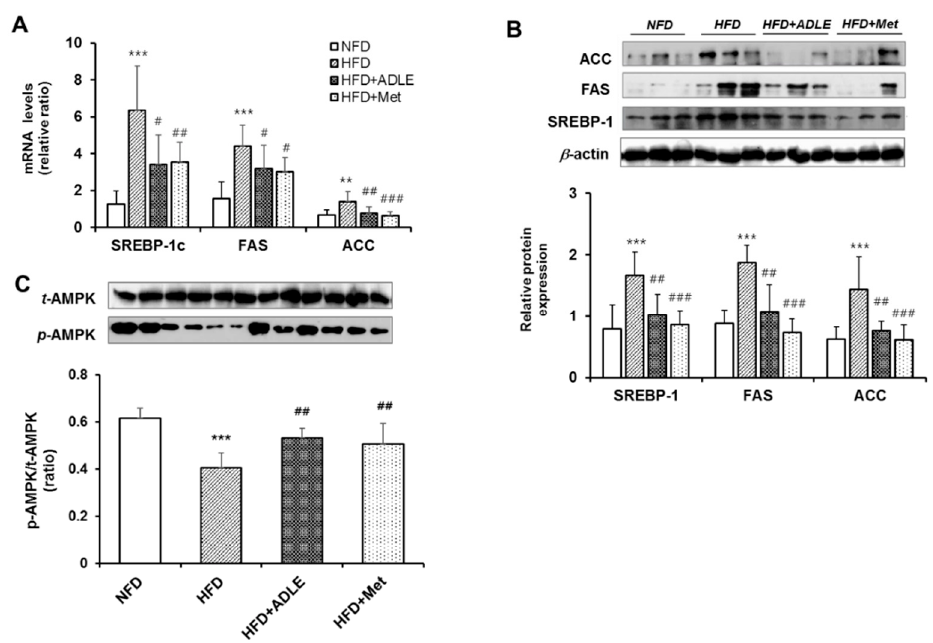
Figure 7. ADLE reduced the expression of lipogenic genes and dephosphorylation of AMPK in the liver of HFD-induced diabetic mice. Mice were treated as described in Figure 1. After 6 weeks of ADLE treatment, total RNA and protein were extracted from the liver as described in the Materials and Methods section. ( A ) The qRT-PCR analysis of gene expression for SREBP-1c, FAS, and ACC was normalized with those of cyclophilin. ( B ) Protein expression levels of SREBP-1, FAS, and ACC were measured by western blot analysis. The intensity of the bands was quantified by densitometric analysis and normalized with corresponding β -actin. ( C ) Western blots of phosphorylated AMPK (pAMPK) in the liver were performed, and the intensity of the bands was quantified by densitometric analysis and normalized with AMPK. Results are calculated as the means ± SD ( n = 6–8). ** p < 0.01 and *** p < 0.001 vs. NFD group. # p < 0.05, ## p < 0.01, and ### p < 0.001 vs. HFD group. NFD, normal-fat diet;